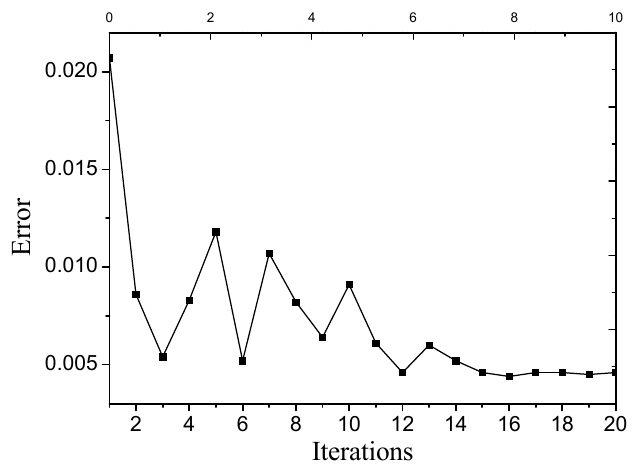
Figure 7. Optimal solution and performance tracking after 20 iterations. Table 4. Identification results of model remaining parameters.